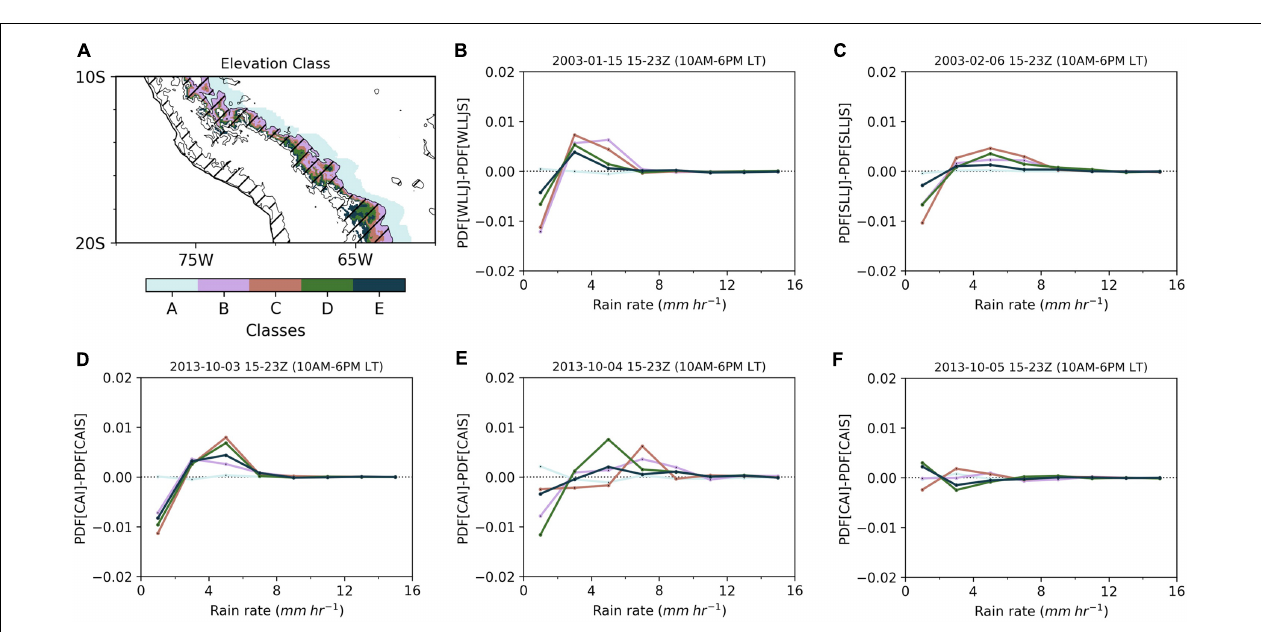
Frontiers in Environmental Science |